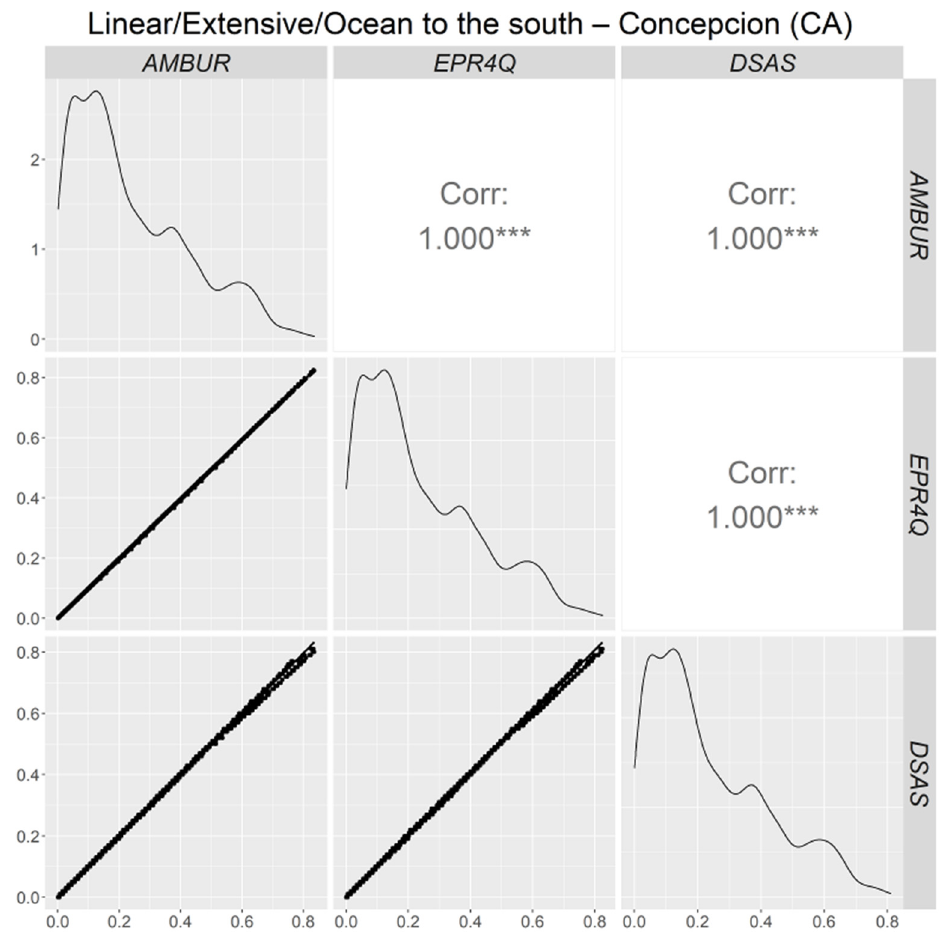
Figure 6. Matrix correlation of AMBUR, EPR4Q, and digital shoreline analysis system (DSAS) models on Linear/Extensive/Ocean to the south for Concepcion coast. p-value significance symbols: “***”—0.001; “**”—0.01; “*”—0.05; “.”—0.1; No symbol —1. The matrix correlation shows the scatter plot between the models (EPR4Q × DSAS, EPR4Q × AMBUR, AMBUR × DSAS) on the left side. The frequency curve of the histogram of each model on diagonal and Pearson’s correlation is presented on the right.